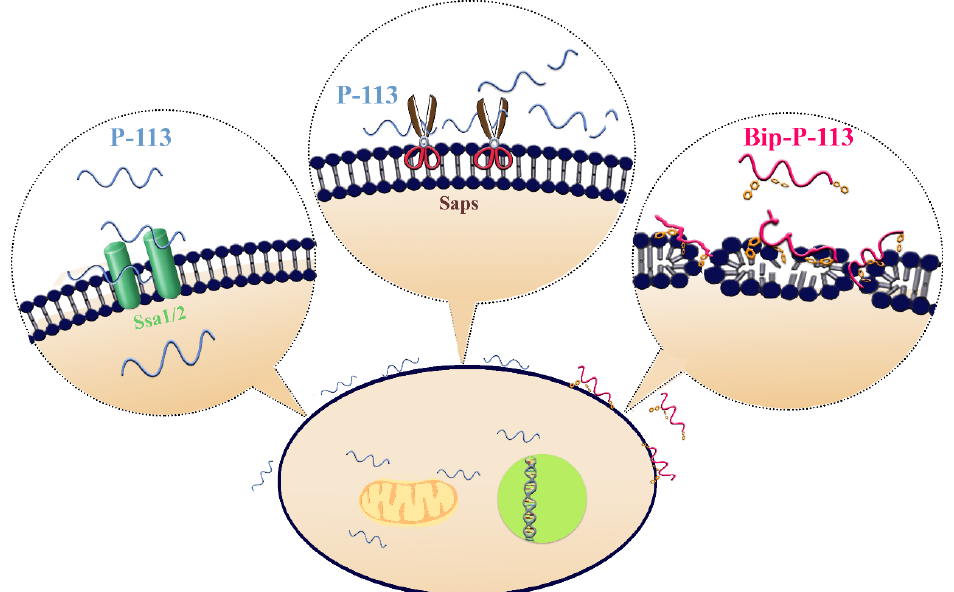
Figure 11. Model of the proposed interactions of P-113 and Bip-P-113 with Candida albicans . P-113 peptides recognize and bind to Ssa1 / 2 proteins and then translocate to the cytoplasm, leading to cell death. However, some of P-113 peptides are degraded by C. albicans secreted aspartic proteases (Saps). In contrast, Bip-P-113 accumulates in cell membrane and induces pore formation.